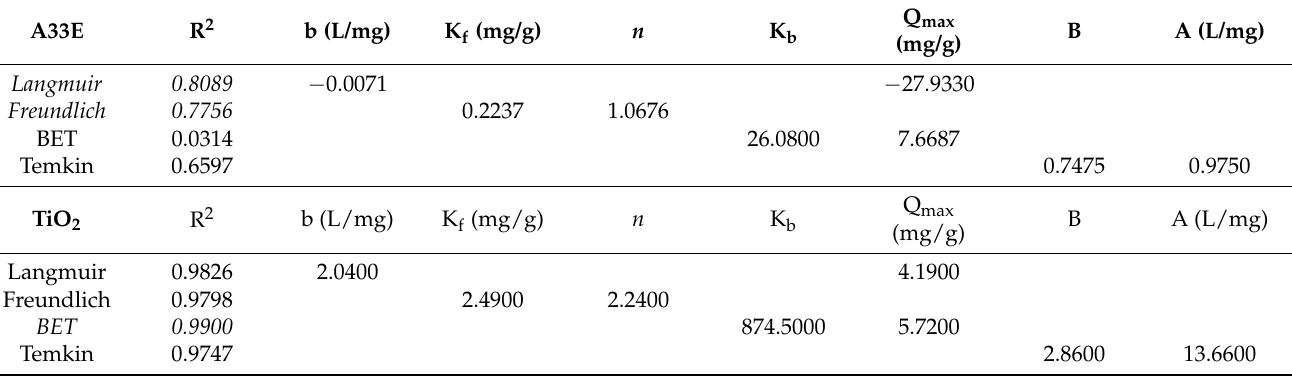
Table 7. Significant parameters related to the various isotherm models for initial